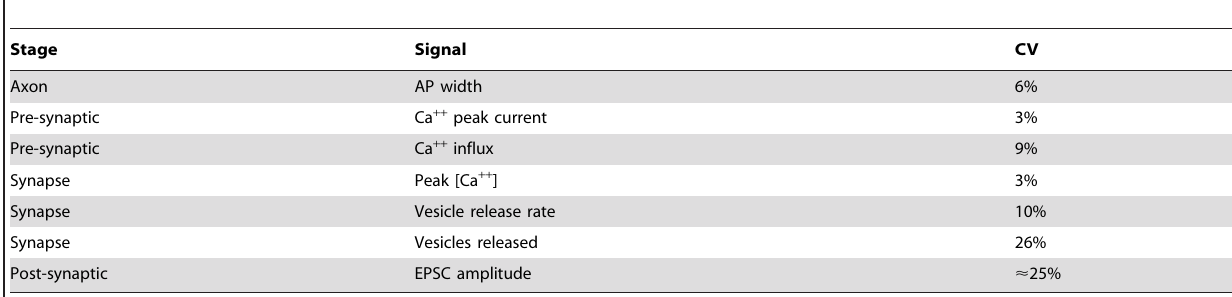
Table 1. Computed signal variability in the successive stages of synaptic transmission for a Calyx-of-Held type synapse (Coefficient of Variation, CV= SD/MEAN) driven by a 0.2